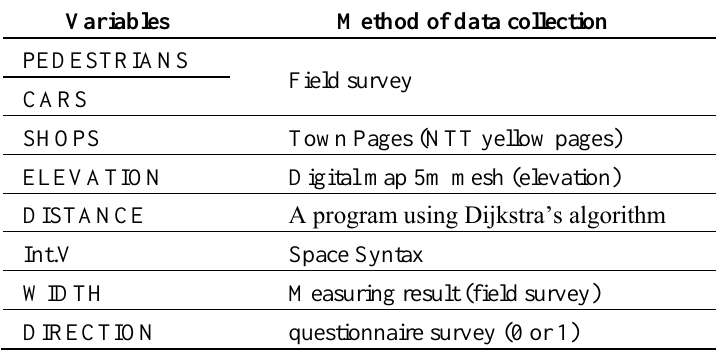
Table 1. Variables and how they are